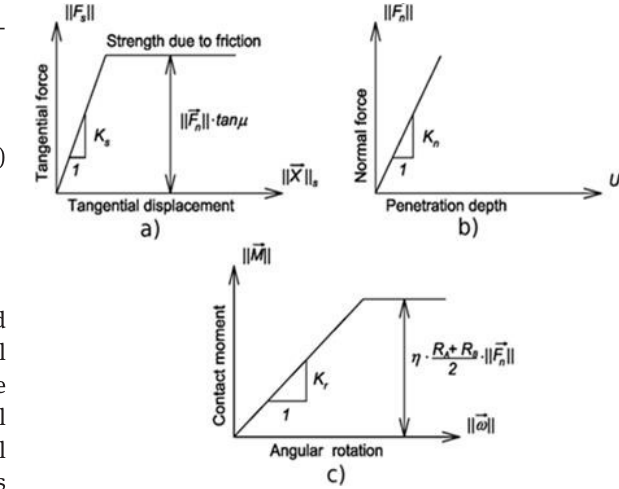
are the k th components of the Figure 2: Mechanical response of (a) tangential (b) normal and (c) rolling contact model laws